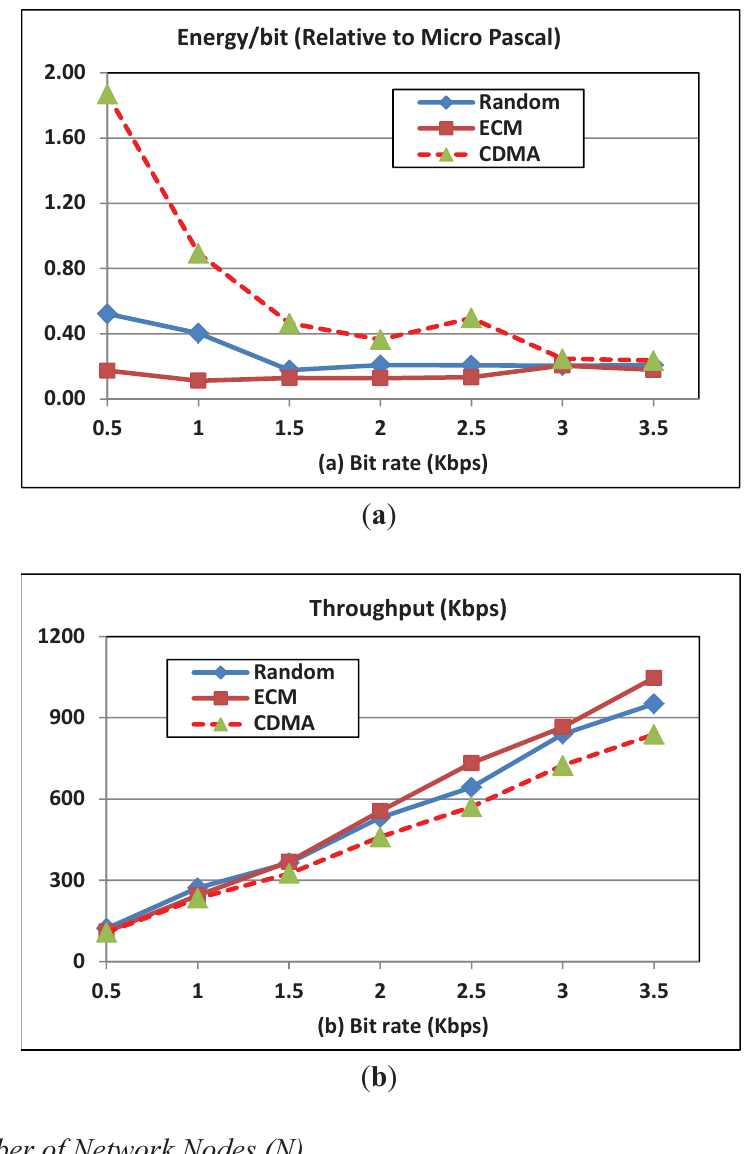
Figure 3. ( a ) Energy per transmitted bit; ( b ) Throughput for OFDMA and CDMA with data rate. BW = 24 KHz; N = 100; Number of subcarriers =